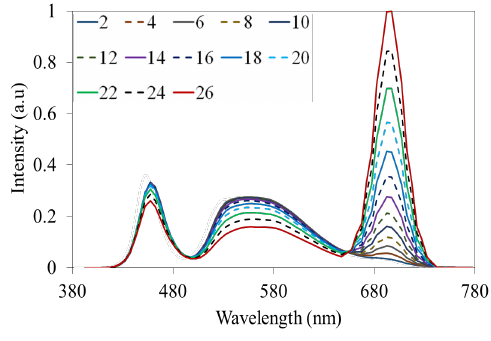
Fig. 6: The emission spectra of 5600 K WLEDs as a function of Sr w F x B y O z :Eu 2+ , Sm 2+ concentra- tion (2% ÷ 26%).